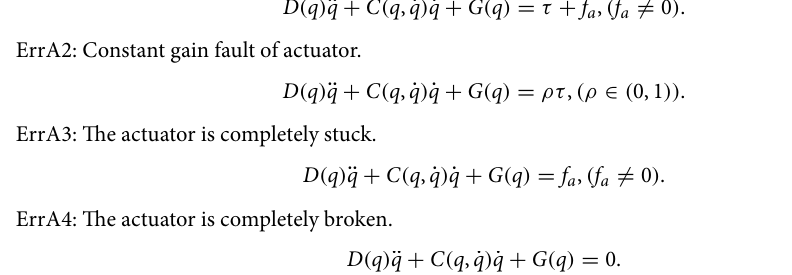
Table 1 concludes above mentioned actuator fault types. Fault model of robot joint sensor.